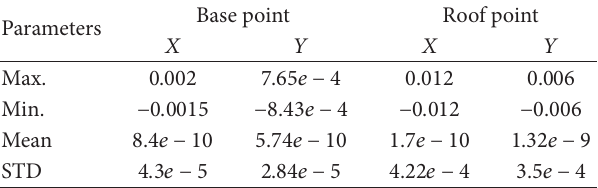
Table 4: Dynamic displacement for the base and roof points (cm). Parameters